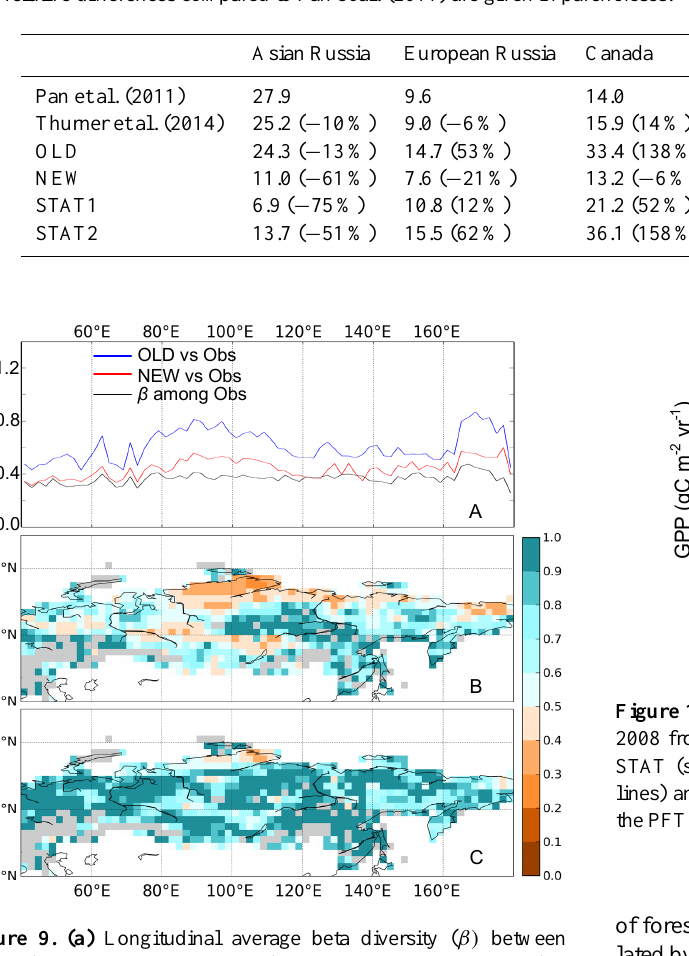
Figure 9. (a) Longitudinal average beta diversity ( β) between model (OLD, blue, and NEW, red) and observational data sets (in- cluding ESA, GLC, VCF, OSIB and IIASA) and between different observations (black) in Siberia. β ranges from 0 to 1.4, with higher values representing larger disagreement. (b) and (c) : Model skill at simulating vegetation distribution ( S V ) for OLD and NEW in Siberia. S V ranges from 0 to 1, with higher values representing bet- ter model performances, integrating observational uncertainty. The pixels where S V > 1 for both models, indicating that the observa- tional data have too large uncertainties to be qualified for model evaluation (12% of the total land points in Siberia), were masked out (in gray).